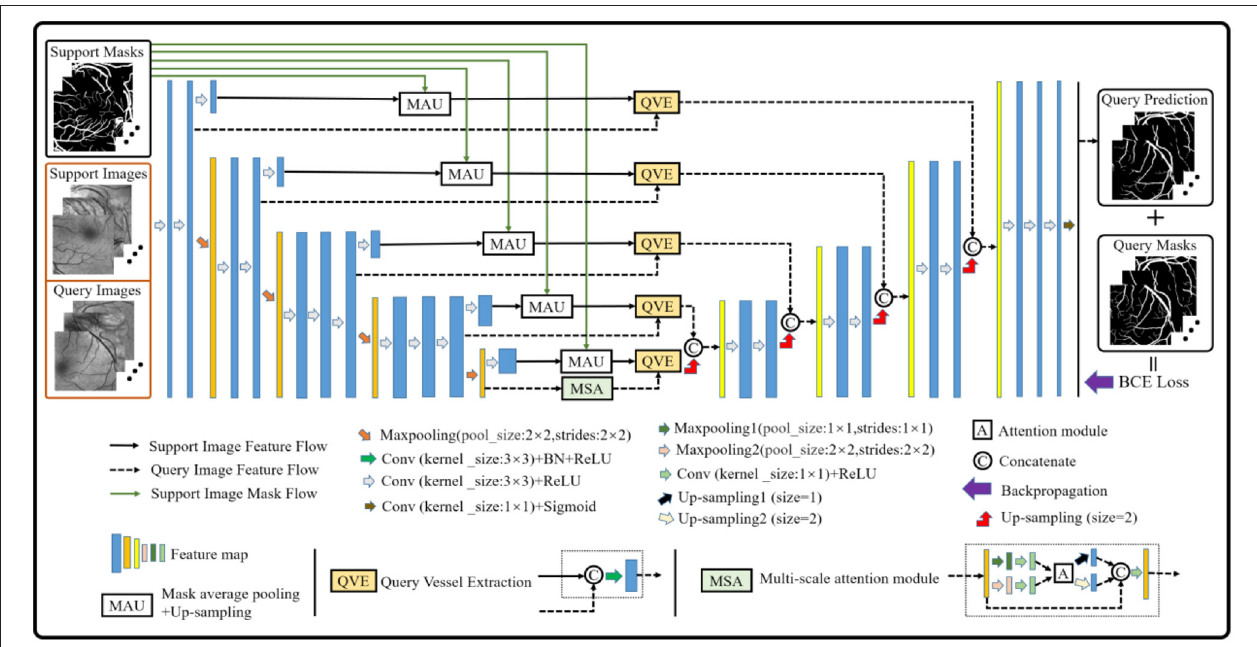
FIGURE 3 | An overview of the upgraded